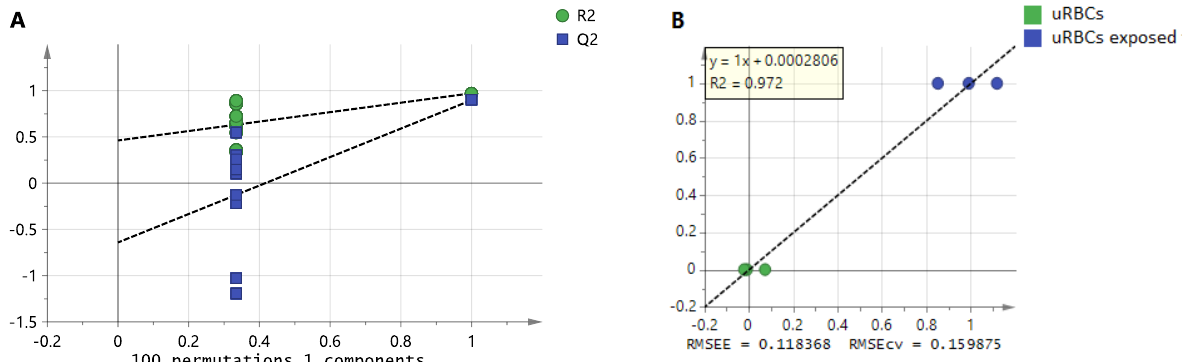
Figure 7. The OPLS-DA models’ validation of uRBCs-control and uRBCs-AG: ( A ) 100 permutations test; ( B ) the validation regression plot. uRBCs, uninfected red blood cells; AG, andrographolide.